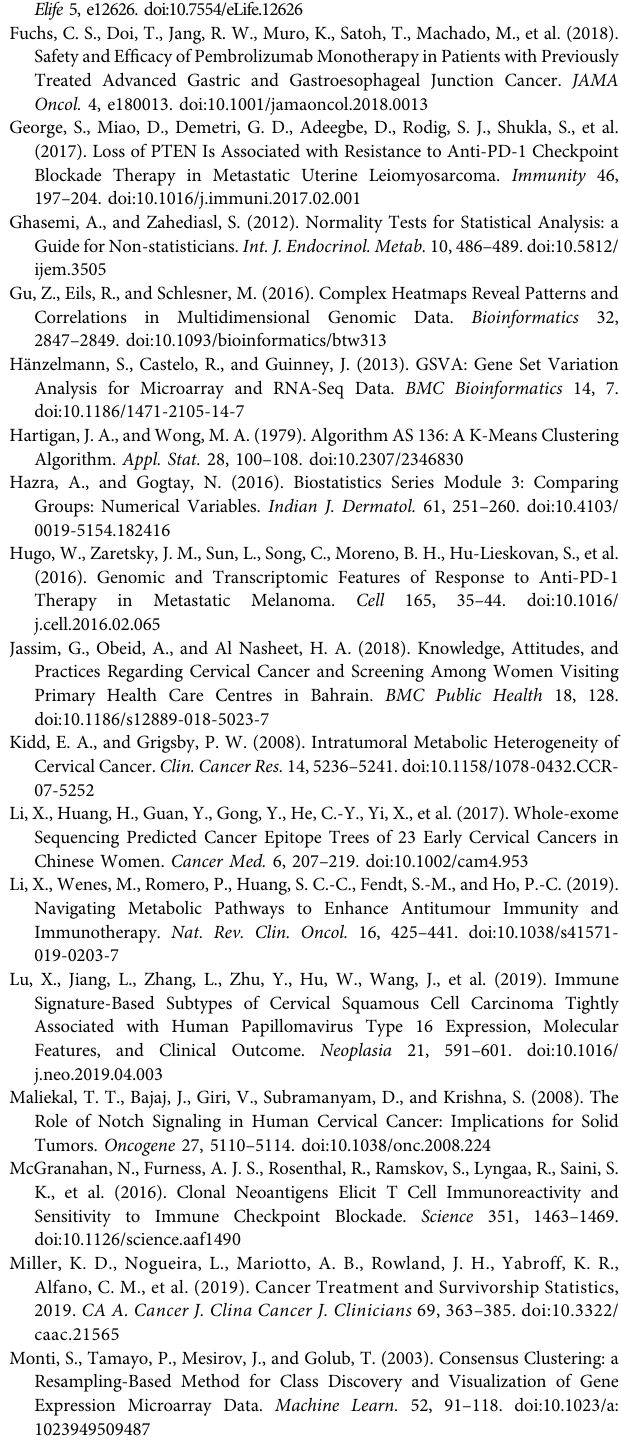
Supplementary Figure 1 | A fl ow diagram for the steps of this study. Supplementary Figure 2 | The clustering map of metabolic genes and immune checkpoints expression (normalized